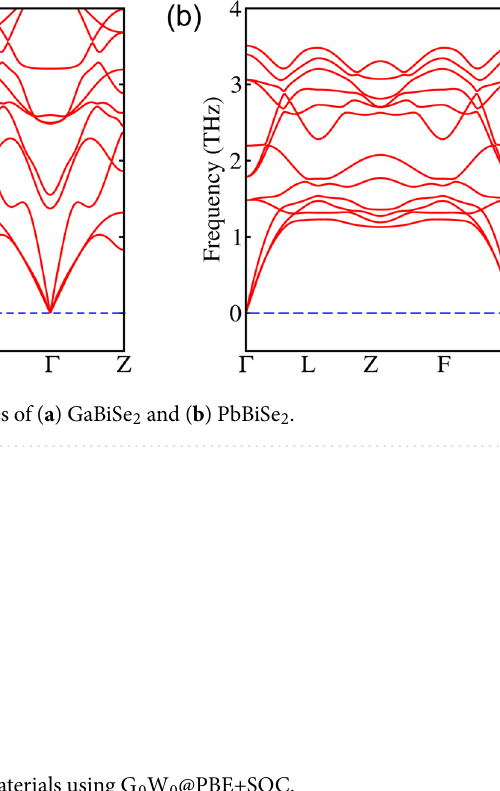
Table 2. Band gap of different materials using G 0 W 0